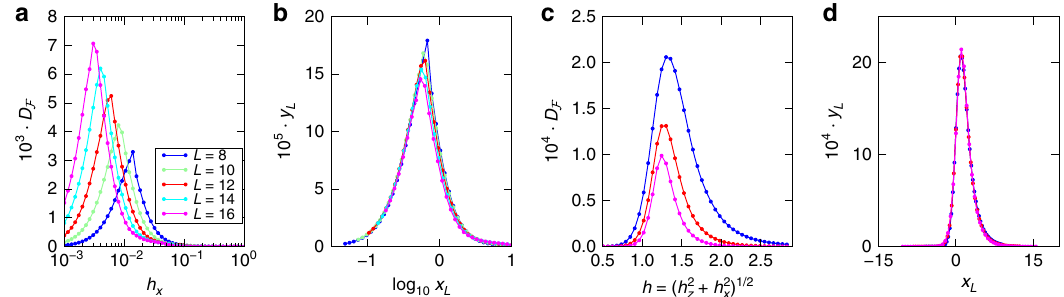
Figure 2 | Finite-size scaling of the interaction distance for the Ising model. D F for a number of systems sizes of ( a ) the FM model and ( c ) the AFM model along the dashed lines given in Fig. 1. We obtain the critical exponents n FM E 0.533, z FM E (cid:3) 1.4 and n AFM E 1.252, z AFM E 1.11 by fitting to (4). ( b , d ) show the scaling collapse of D F , where x L ¼ ( g (cid:3) g c ) L 1/ n and y L ¼ D F L z . This demonstrates the applicability of the scaling ansatz (4).